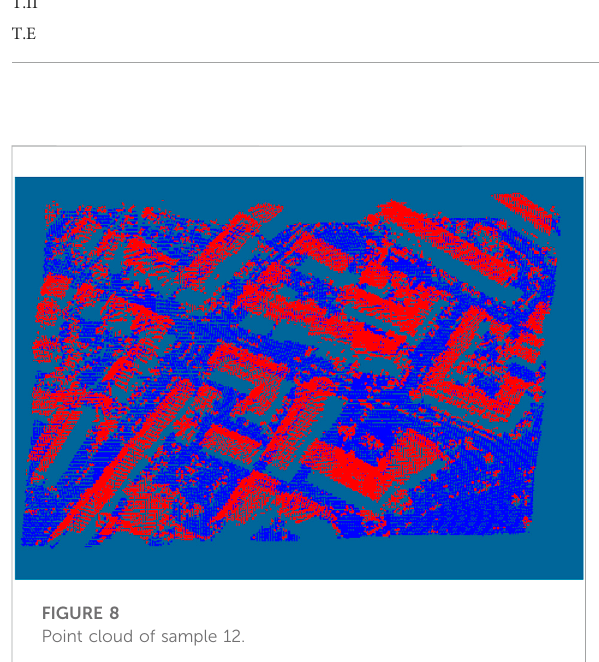
category (Figure 8), where blue points are real ground points and red points are real non-ground points.